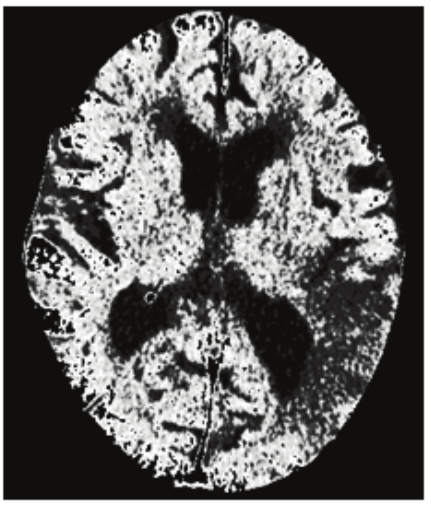
Figure 6: Image obtained after executing the